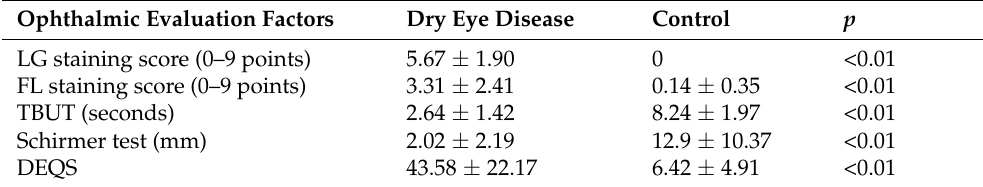
Table 2. The average values of ophthalmic evaluation factors in patients and controls. Ophthalmic Evaluation Factors Dry Eye Disease Control p LG staining score (0–9 points) 5.67 ±